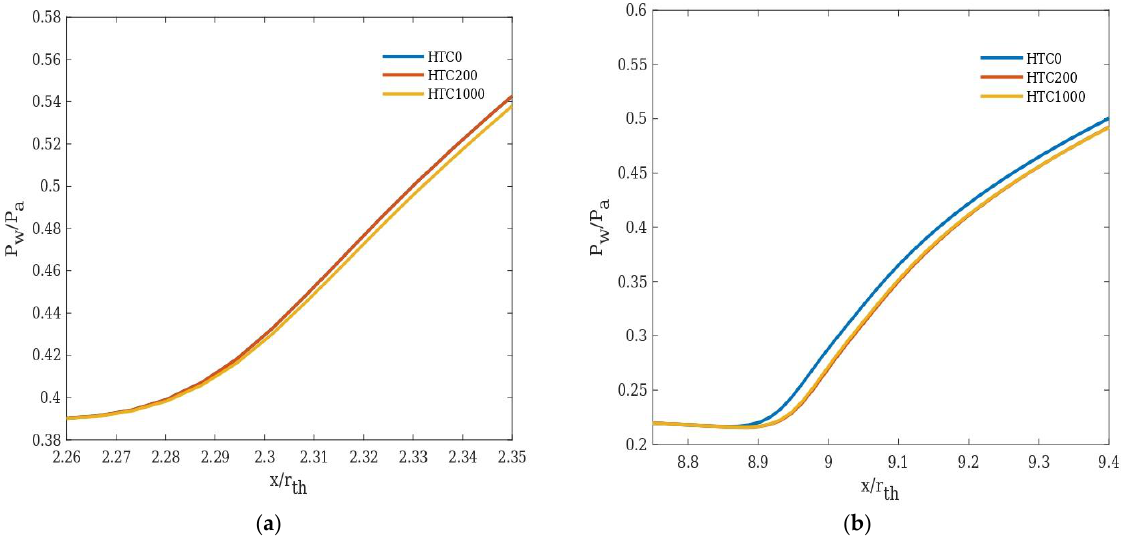
Figure 13. Wall pressure distribution at an inlet temperature of 1200 K for different heat transfer coefficients: ( a ) NPR 14 and ( b ) NPR 40.